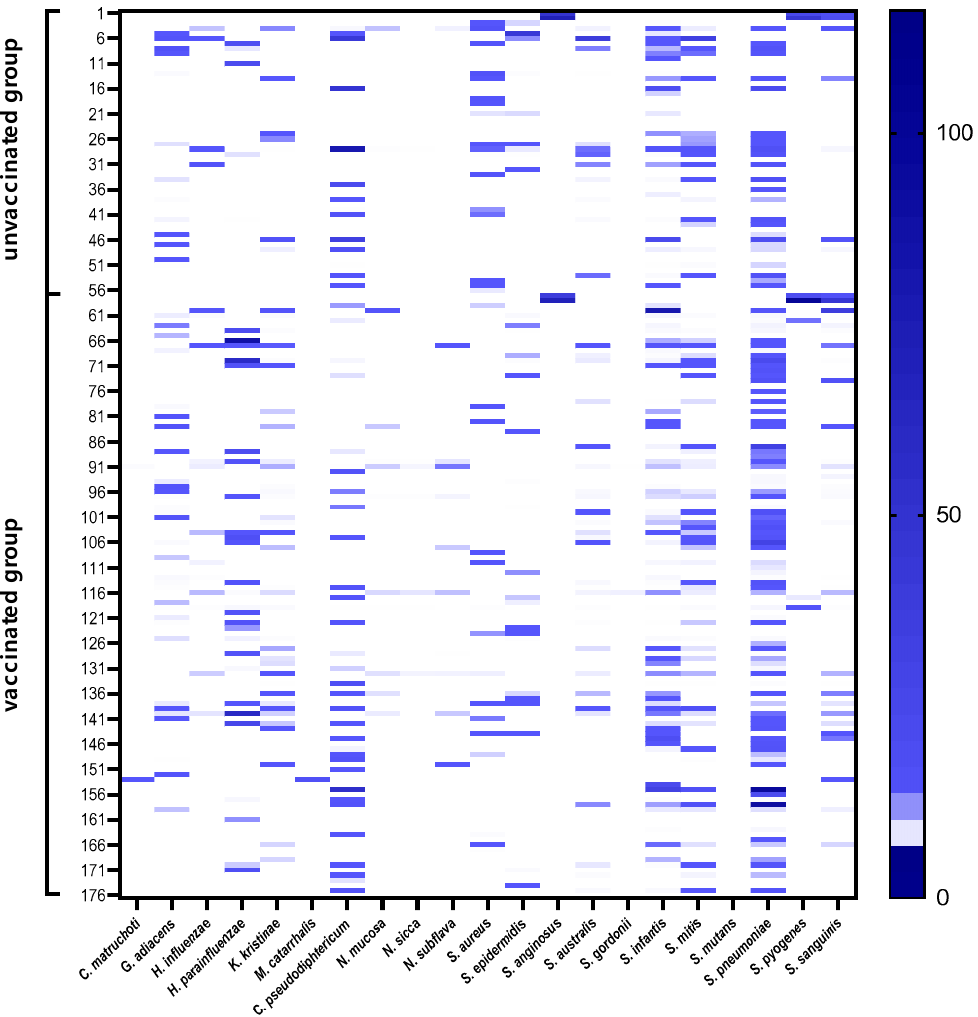
Figure 3. Heat map showing the relative abundance of species/genera genes across 176 samples. For identification of microbial species or microbial genes, the ∆ CT method was used. The 2 - ∆ CT data transformation was used.